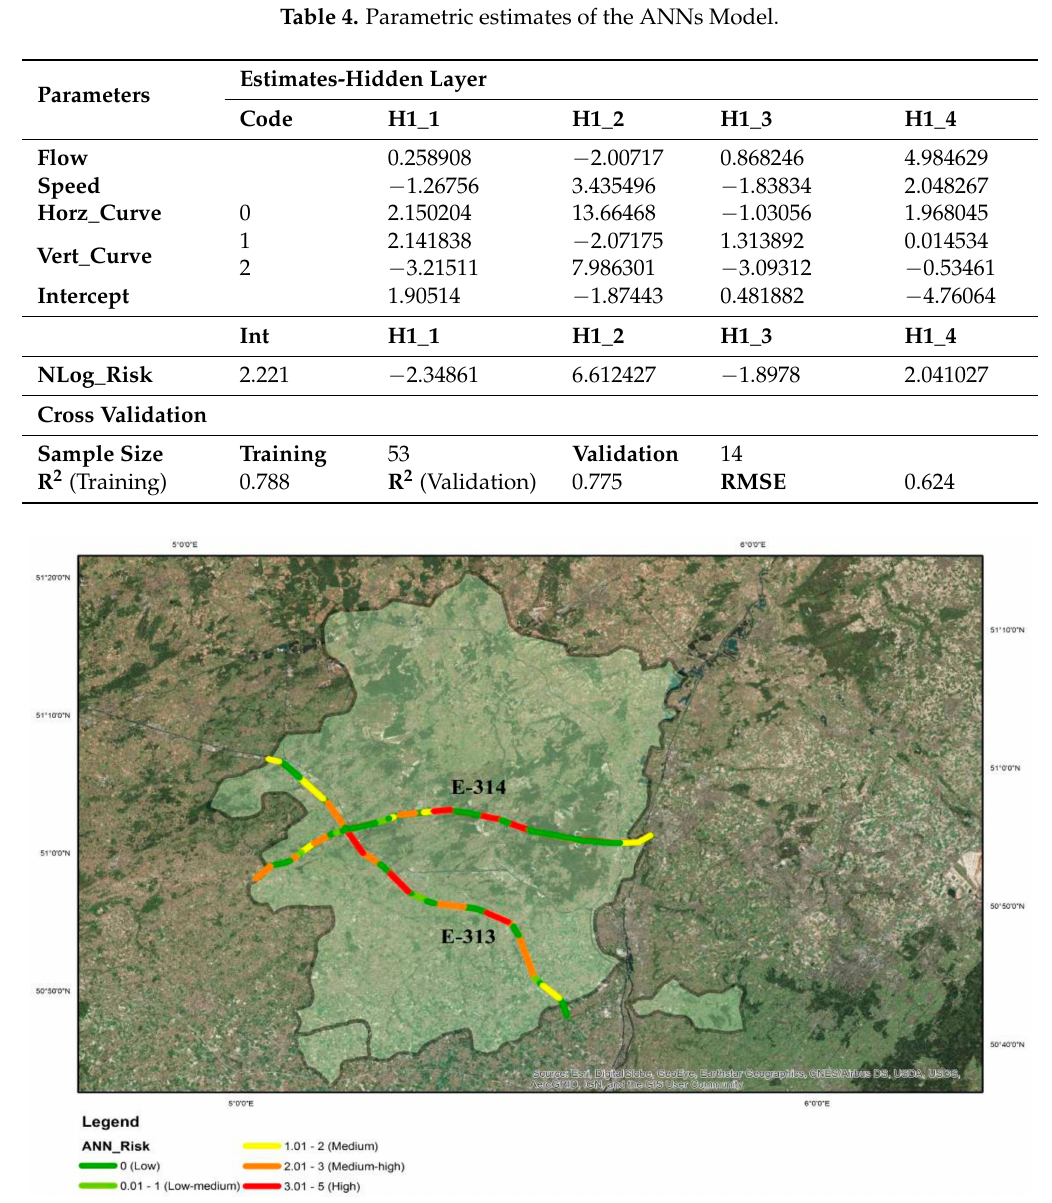
Figure 4. Geographical information system (GIS)-based ANNs-predicted risk spatial